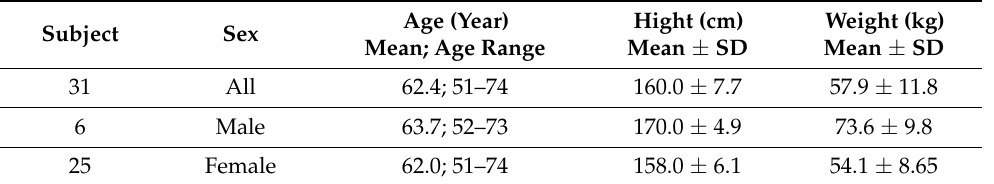
Table 1. Physical characteristics of the participants (SD—standard